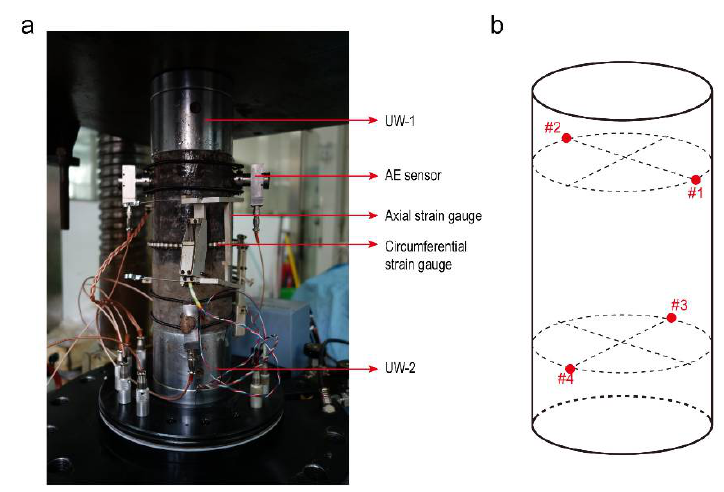
Figure 3. ( a ) Diagram of ultrasonic velocity and AE testing for salt rock under uniaxial stress; ( b ) AE sensor’s layout, #1, #2, #3, and #4 = the sensor’s number.